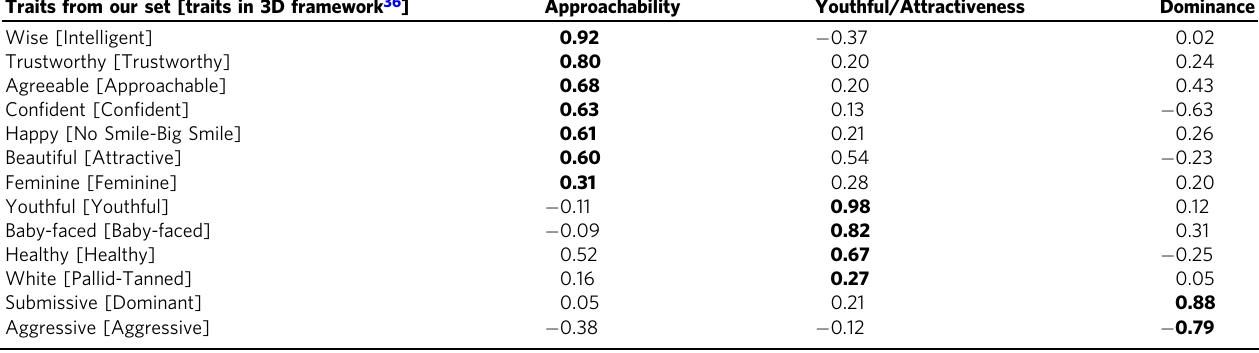
Table 2 Factor loadings from EFA on subsets of 13 traits used in the 3D framework. Factor loadings from EFA on the subset of data corresponding to 13 traits ( fi rst column) that are the same or most similar to those used in a prior study that discovered the popular 3D framework[36] ( fi rst column, in brackets). Three factors — the optimal number of factors as indicated by Cattell ’ s Scree Test, the optimal coordinates index, Velicer ’ s MAP test, and empirical BIC — were extracted and rotated with oblimin. The largest absolute loading across factors for each trait is highlighted in bold. Source data are provided as a Source Data fi le. Traits from our set [traits in 3D framework 36